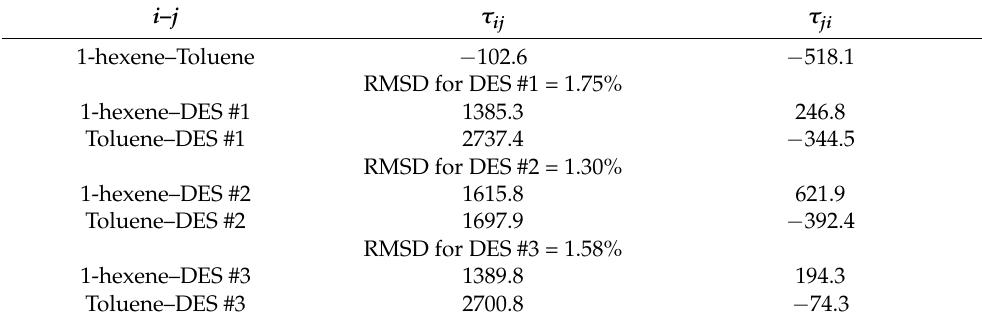
Table S2: COSMO-RS screening results. Tables S3 and S4: Standard deviation STDEV on mea- sured solubilities of 1-hexene (1)/toluene (2) mixture with DES #1 (3) for mole fractions x: Top layer and bottom layer. Tables S5 and S6: Standard deviation STDEV on measured solubilities of 1-hexene (1)/toluene (2) mixture with DES #2 (3) for mole fractions x: Top layer and bottom